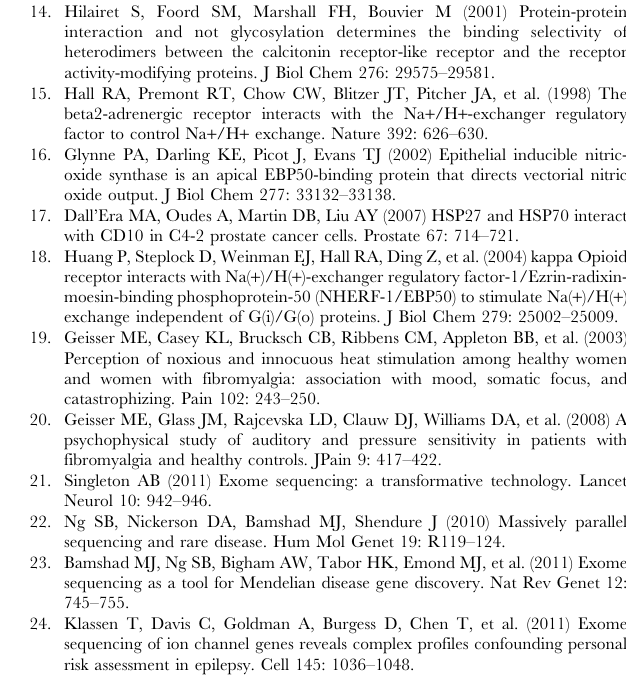
Table S1 Details of exome sequencing. Descriptive statistics for variants identified in exome sequencing of TUK1 and TUK2 sample sets. The values were generated from filtered variants for all samples which passed QC. Table S2 Relationship between the 21 rare variants analysis methods used in the TUK1. Heat Map or correlation matrix of the 2 log10 p values (pval) for each pair of 21 methods run